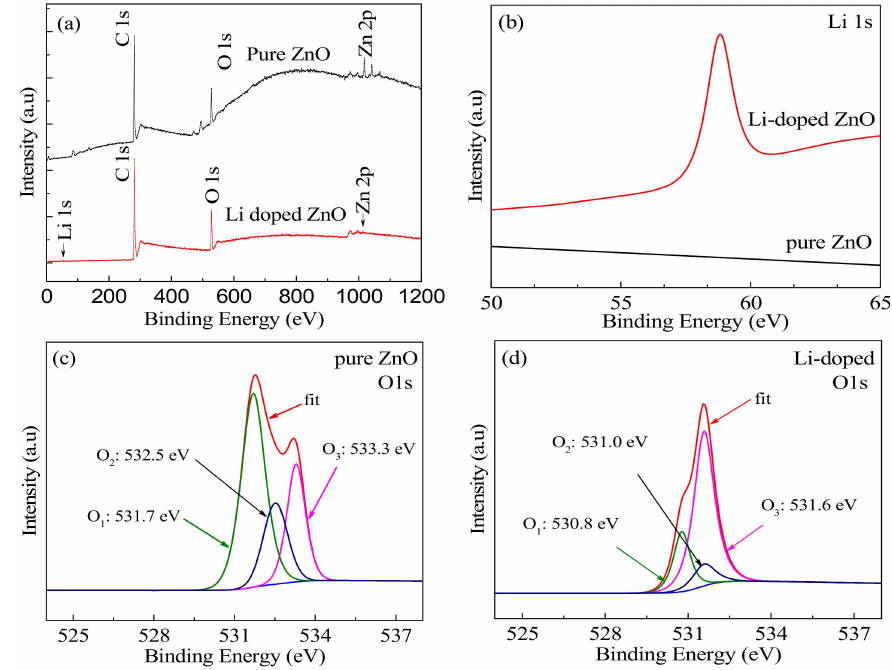
Figure 3. ( a ) XPS survey spectra of pure ZnO and Li-doped ZnO thin films; ( b ) XPS spectra of Li 1s; ( c ) XPS spectra of O 1s in pure ZnO thin film; ( d ) XPS spectra of O 1s in Li-doped ZnO thin